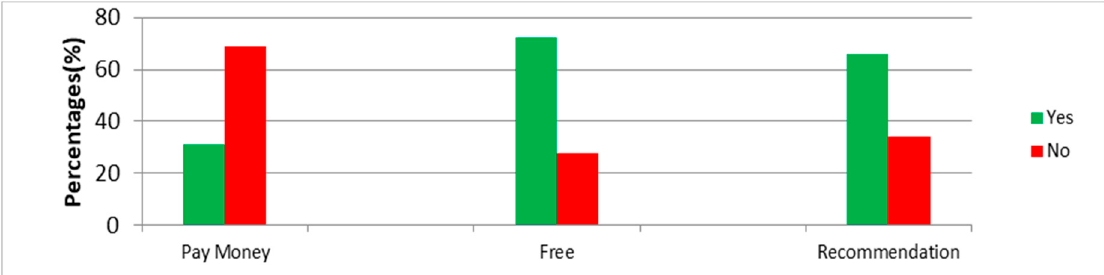
Figure 4. Paying extra money vs free installation of